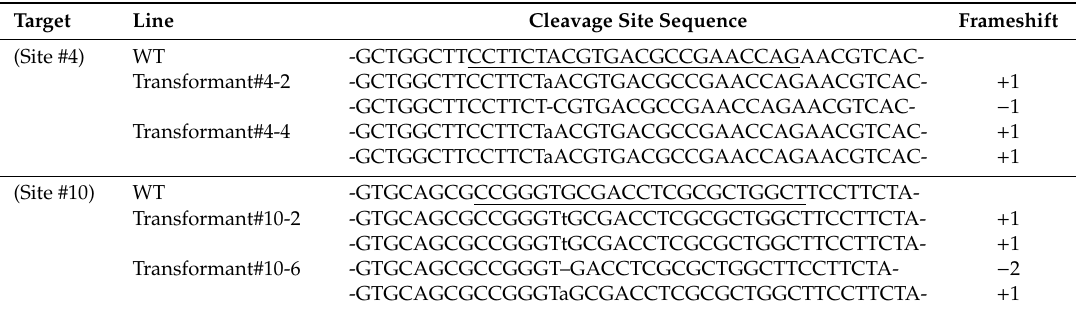
Table 1. Representative oscerk1 mutations induced by transformation with an OsCERK1 -knockout / BSR1 -overexpression vector.